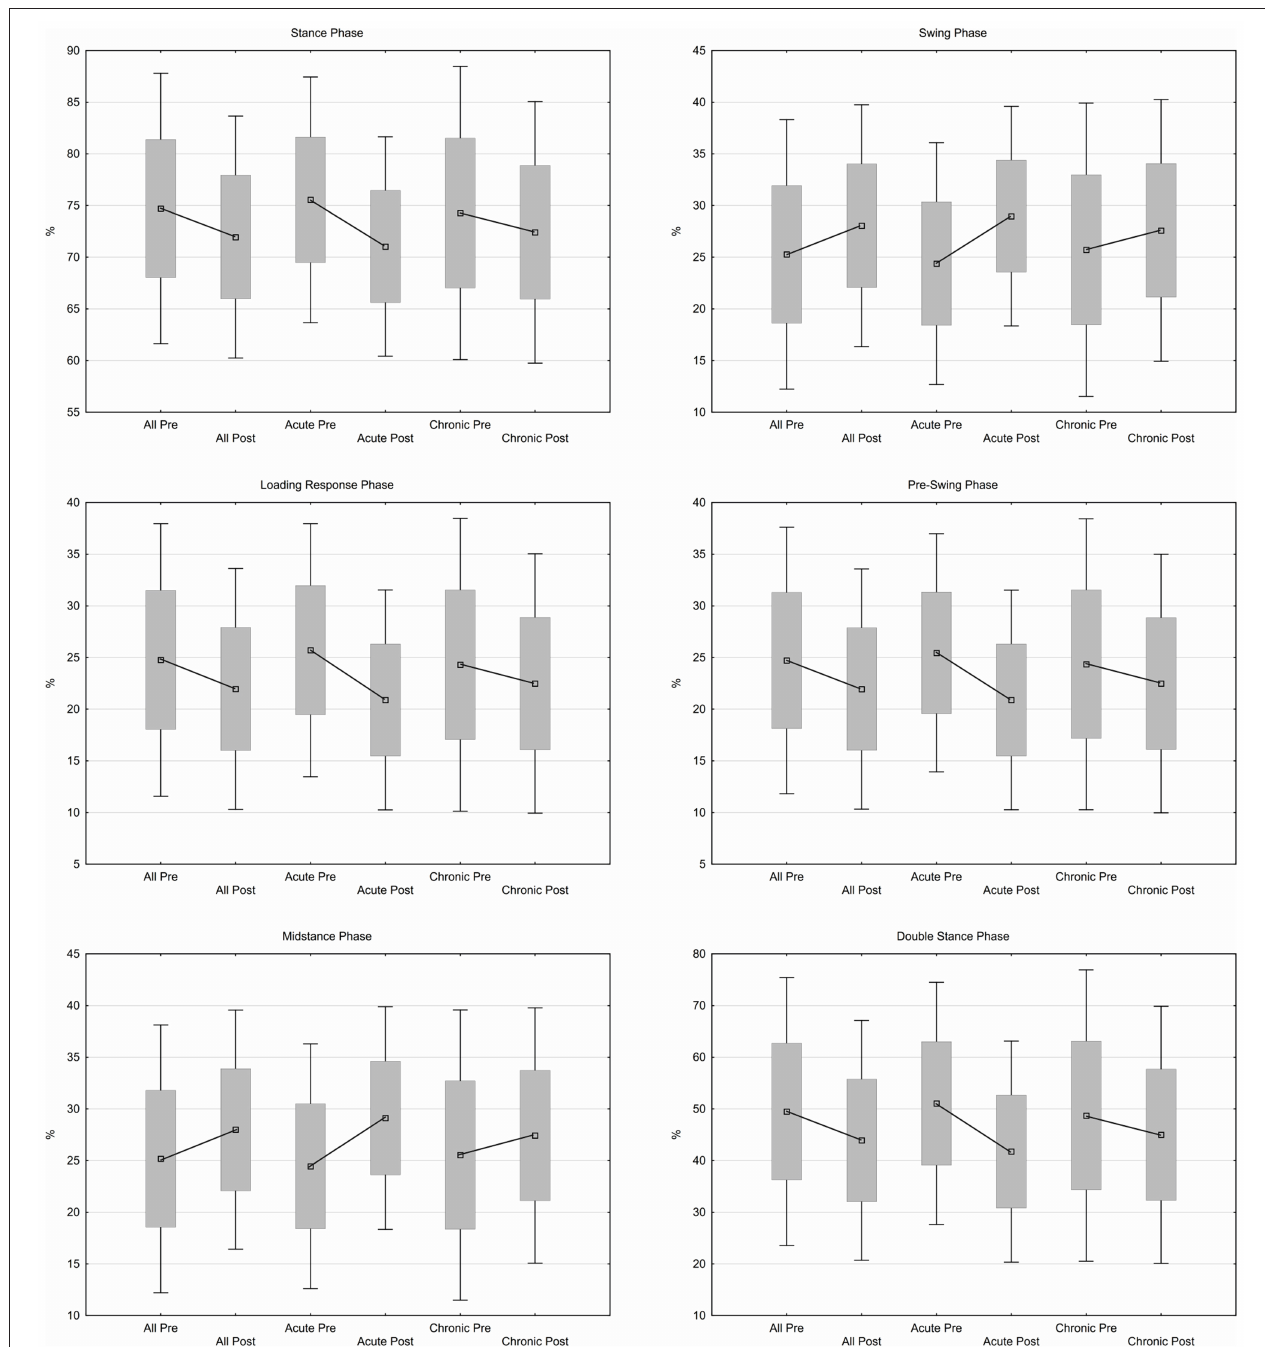
FIGURE 1 | Gait phase